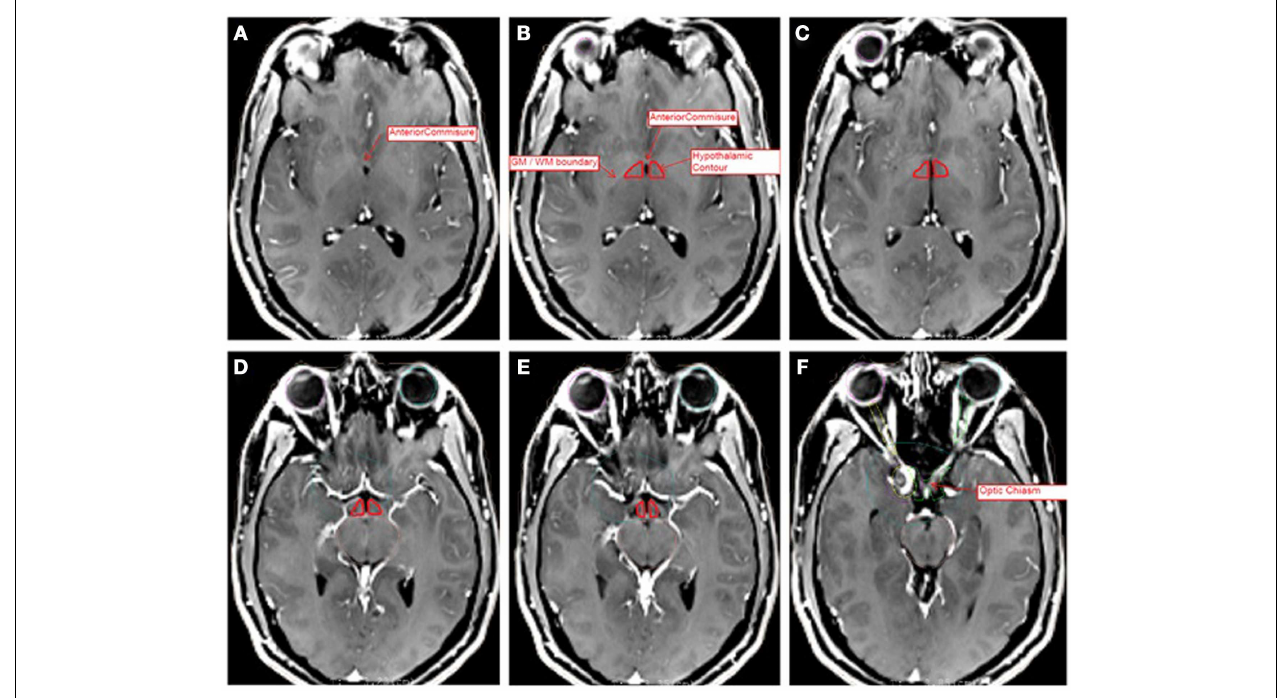
hypothalamic contour, bounded by the white matter tracts laterally, the third ventricle medially, the CSF space of the suprasellar cistern anteriorly, and the level of the interpeduncular fossa posteriorly. (F) Depicts the level of the optic chiasm, at which the contour ends. The contour has been enhanced for ease of